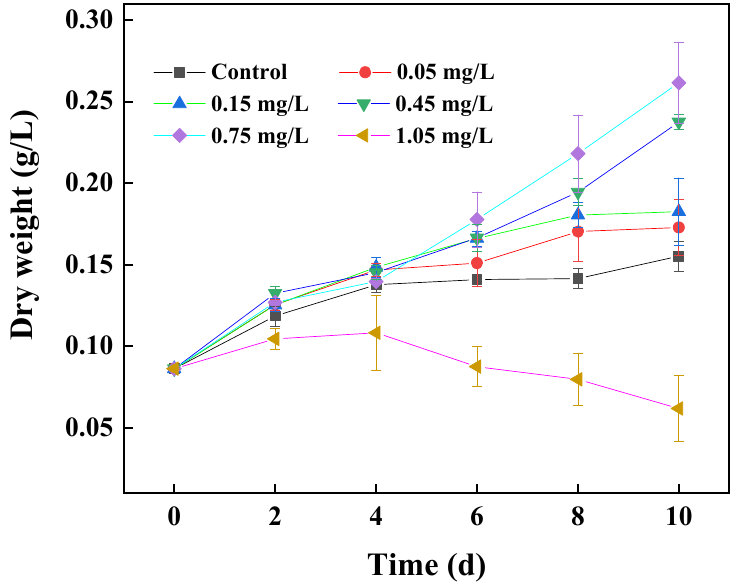
Figure 1. Effect of triclosan on the growth of Chlorella vulgaris.